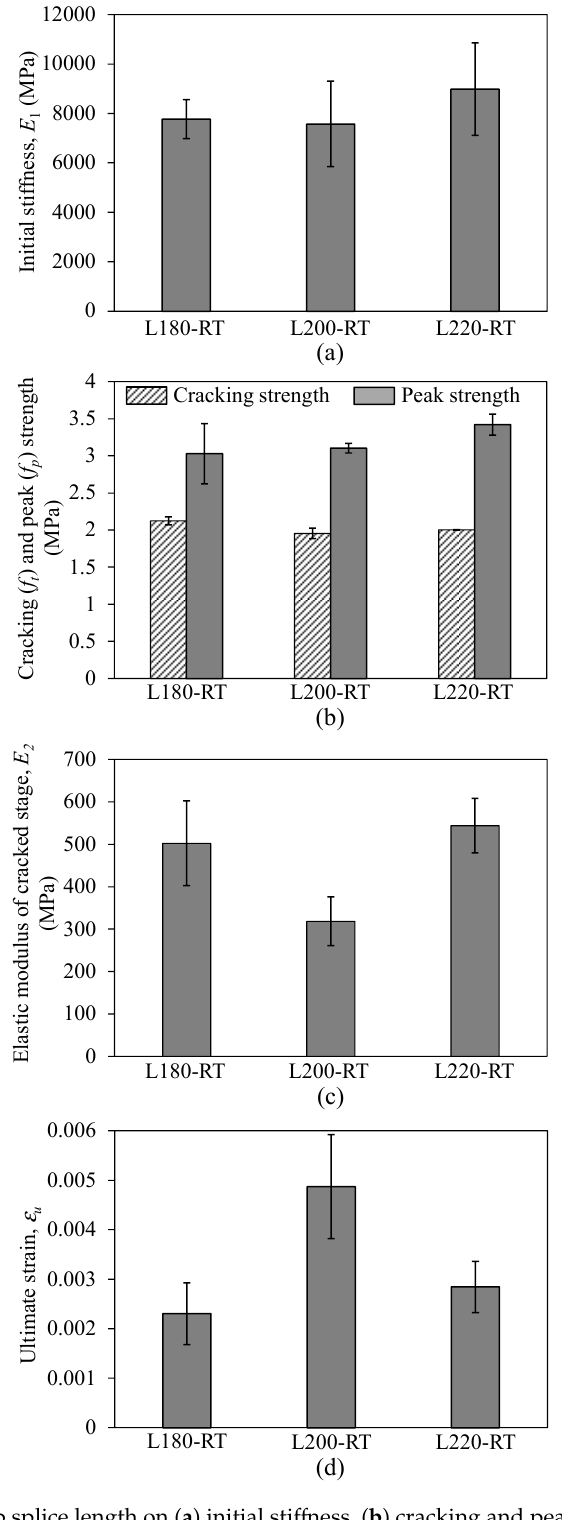
Figure 13. E ff ect of lap splice length on ( a ) initial sti ff ness, ( b ) cracking and peak strengths, ( c ) elastic Figure 13. Effect of lap splice length on ( a ) initial stiffness, ( b ) cracking and peak strengths, ( c ) elastic modulus of cracked stage, and ( d ) ultimate strain of TRM modulus of cracked stage, and ( d ) ultimate strain of TRM specimens.